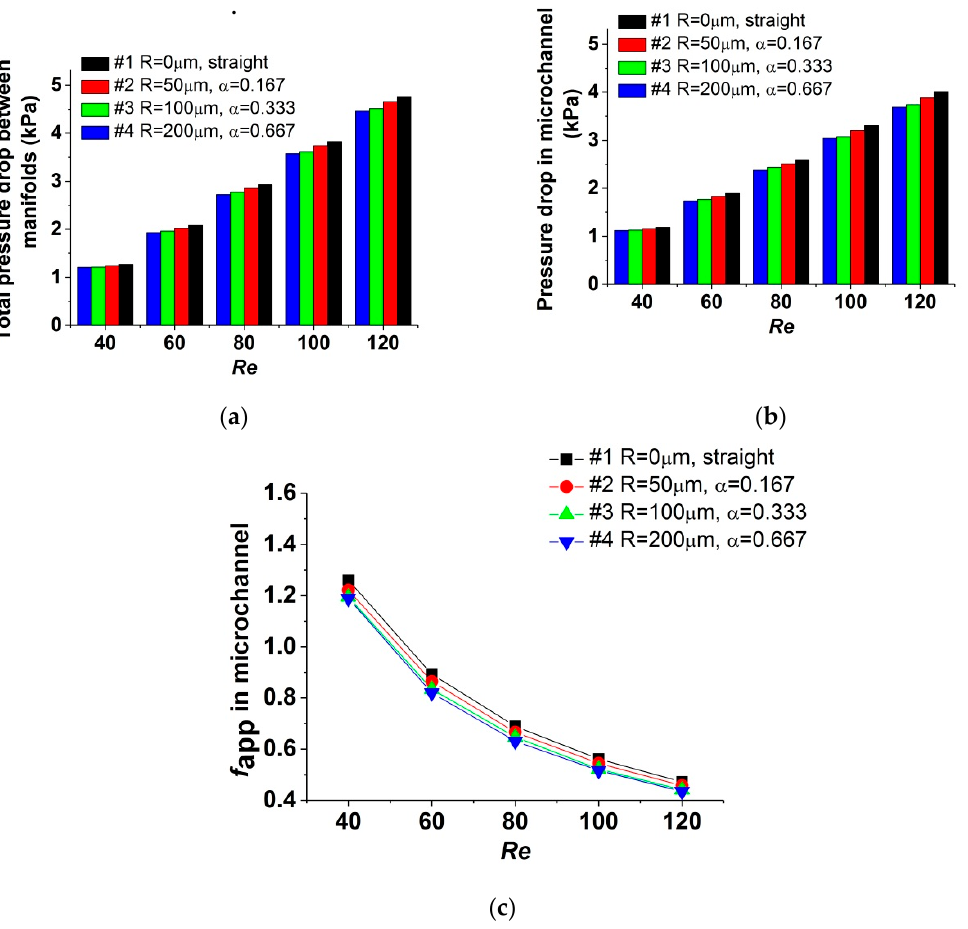
Figure 7. Influence of α on the pressure-drop characteristics when the test sections are heated. ( a ) Total pressure drop between manifolds; ( b ) pressure drop in microchannel; ( c ) fapp in